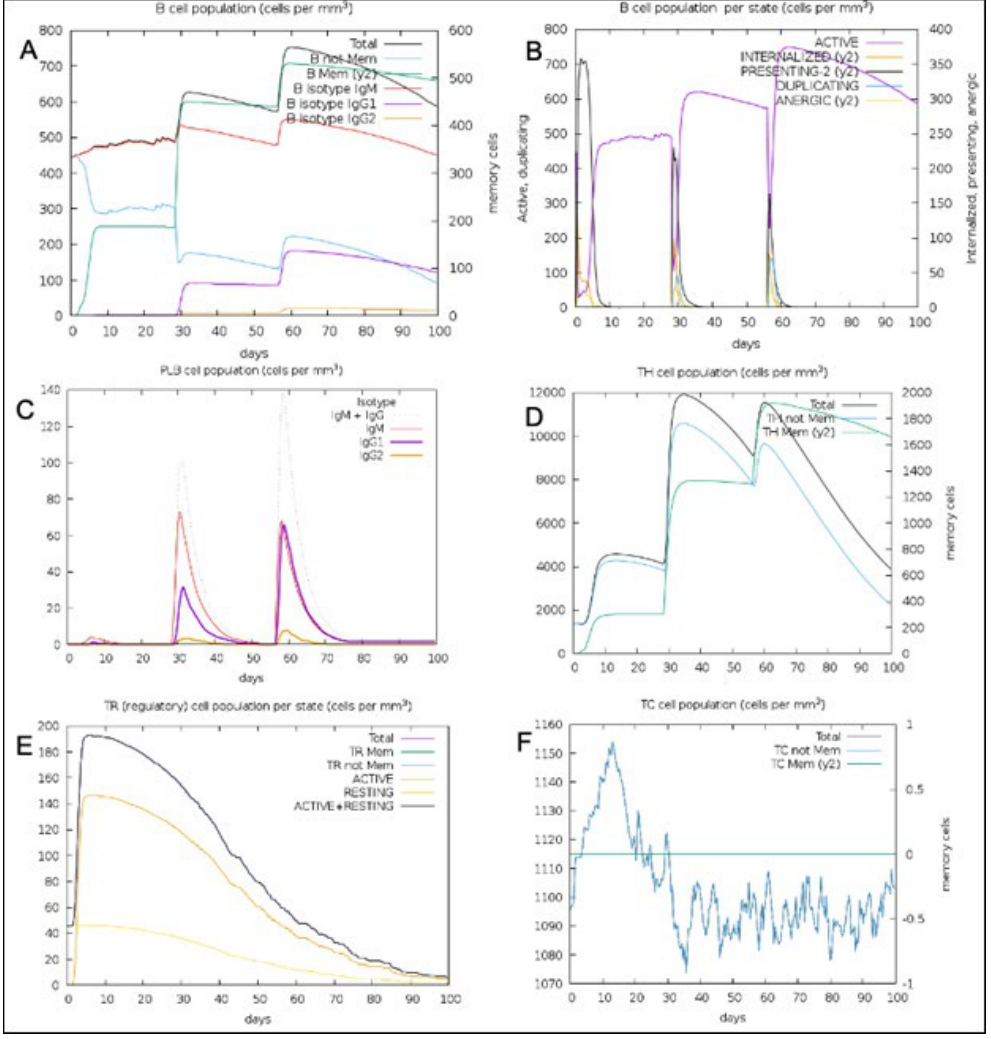
Fig. 11. (A) B-lymphocytes total count (B) B-lymphocyte population per state (C) Plasma B-lymphocytes total count (D) T-Helper cell total count (E) T-Regulatory cells per state (F) T-cell total